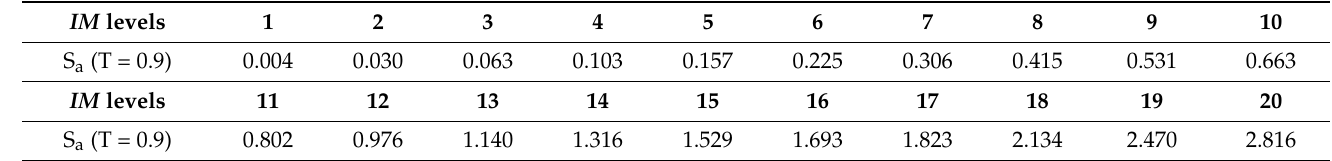
Table 1. Correspondence between IM levels and spectral accelerations (in